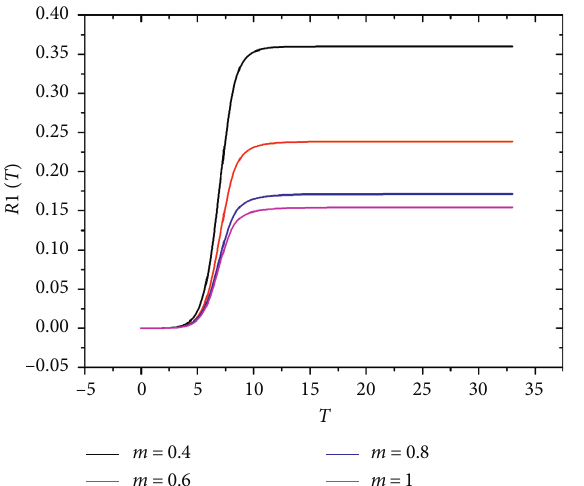
Figure 4: Density of stifler1 over time for different values of m .